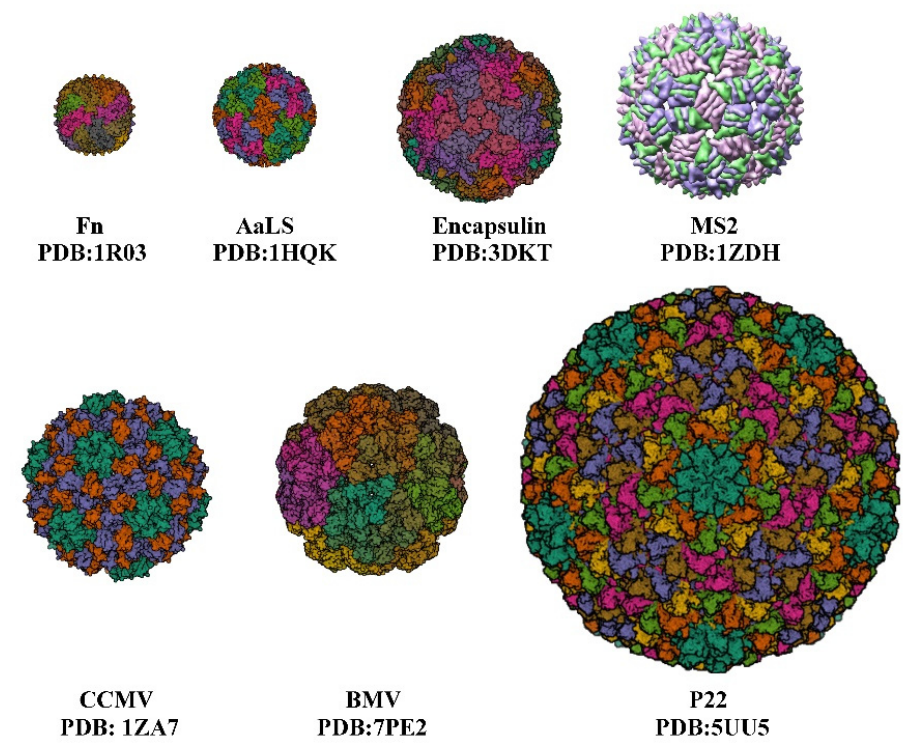
Figure 1. Several protein cages of different sizes. Fn, Ferritin cage; AaLS, Aquifex aeolicus ; encapsulin protein cage; MS2; CCMV, Cowpea chlorotic mottle virus; BMV, Bromemosaic virus; P22, Bacteriophage. Table 1. Several triangulations and external/inner diameters of protein cage NPs.